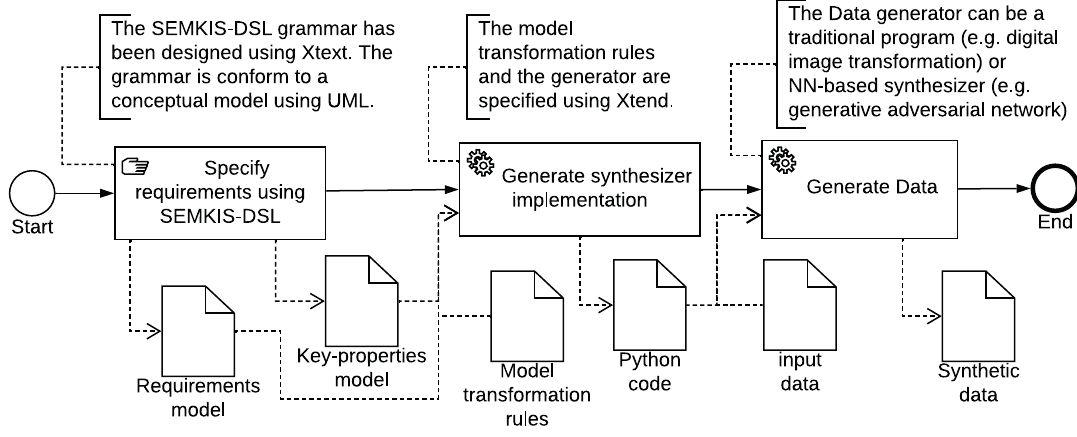
Figure 1. SEMKIS MDE process